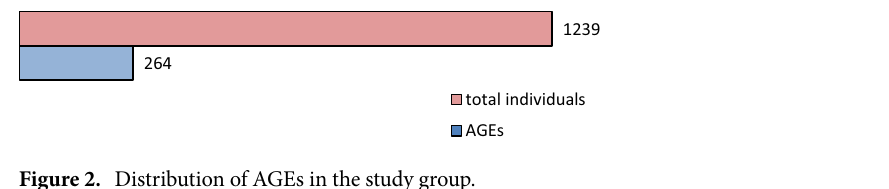
Figure 2. Distribution of AGEs in the study